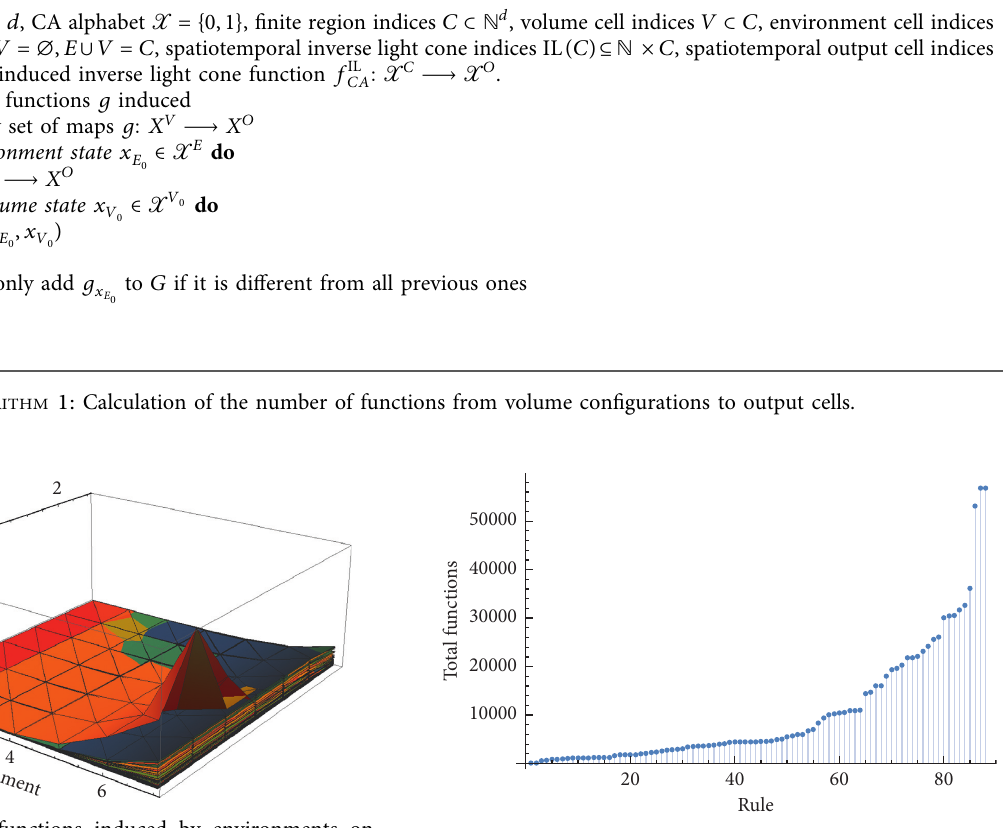
Figure 3: Total number of functions for each of the 88 rules. The ordered list of rules in the plot is as follows: {0, 8, 32, 128, 4, 12,